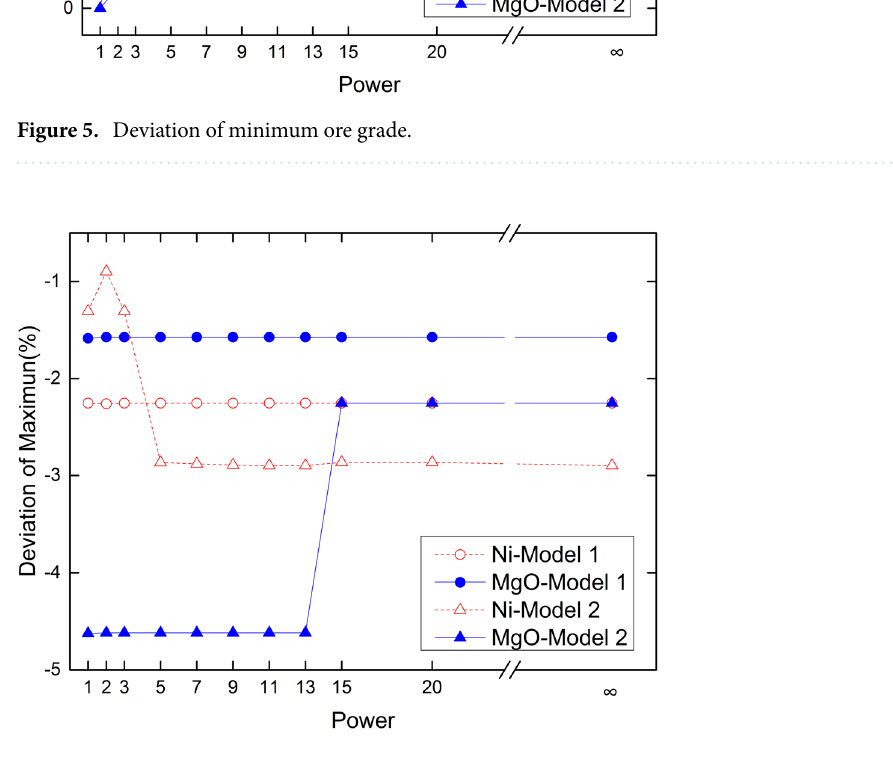
Figure 6. Deviation of maximum ore